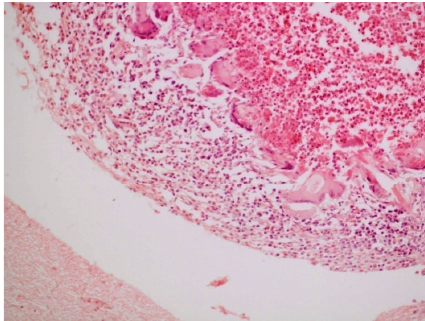
Figure 7: The inflammatory macrophages, a few lymphocytes, plas-